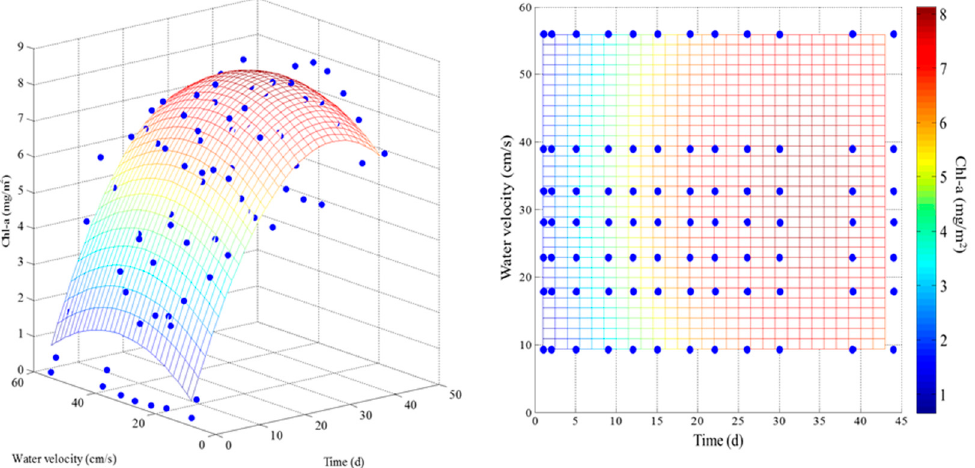
Figure 2. Correlation between independent variables (incubation time and water velocity) and Chl ‐ a using response surface methodology (i.e., Equation (6)) (solid dots represent experimental conditions).